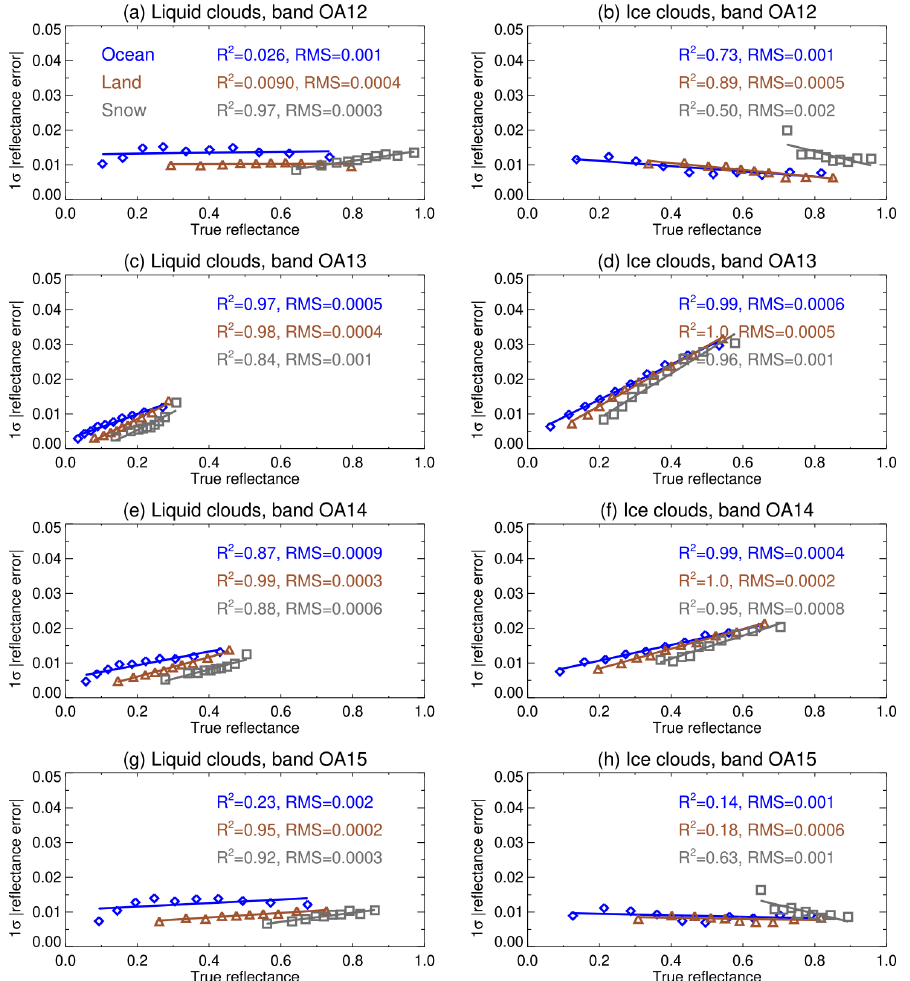
Figure 8. Forward model TOA reflectance uncertainty for OLCI. Left and right columns indicate liquid- and ice-phase cloud simulations, and rows indicate the four OLCI channels used in CHROMA. Points and lines show the binned data and linear fits, with fit coefficients of determination and root mean square error shown in legends. Blue, brown, and grey show ocean-like, land-like, and snow-like surface albedo respectively. Nominal central wavelengths for OLCI channels OA12 to OA15 are 753.75, 761.25, 764.375, and 767.5nm